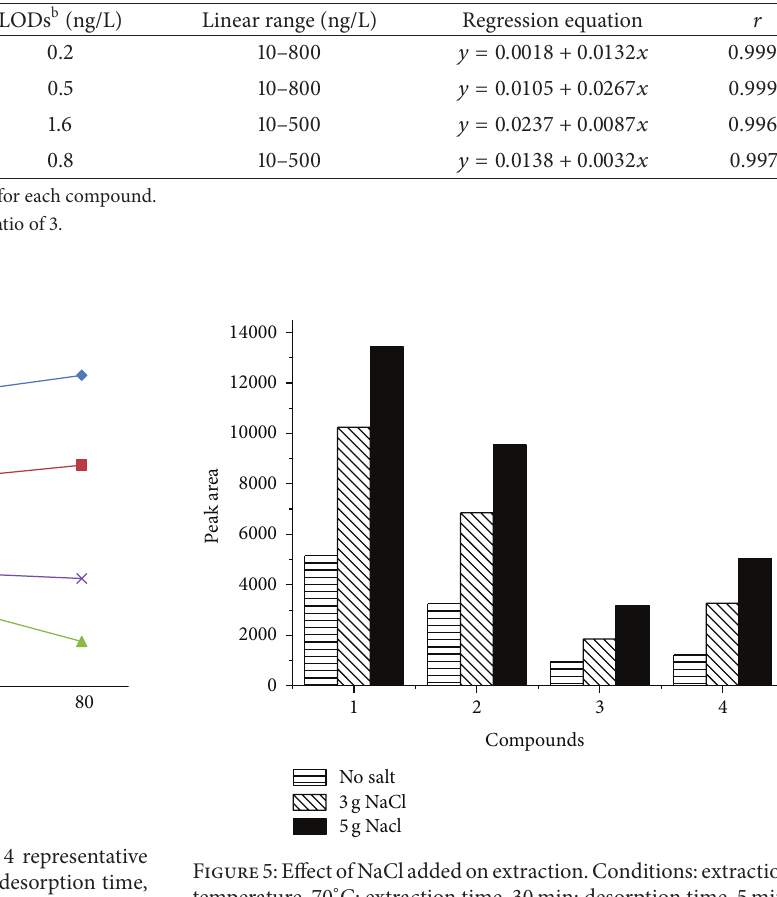
Figure5:EffectofNaCladdedonextraction.Conditions:extraction temperature, 70 ∘ C; extraction time, 30 min; desorption time, 5 min; magnetic stirring. Peaks: 1, n C 17 -alkane; 2, pristine; 3, naphthalene; and 4, 5- 𝛼